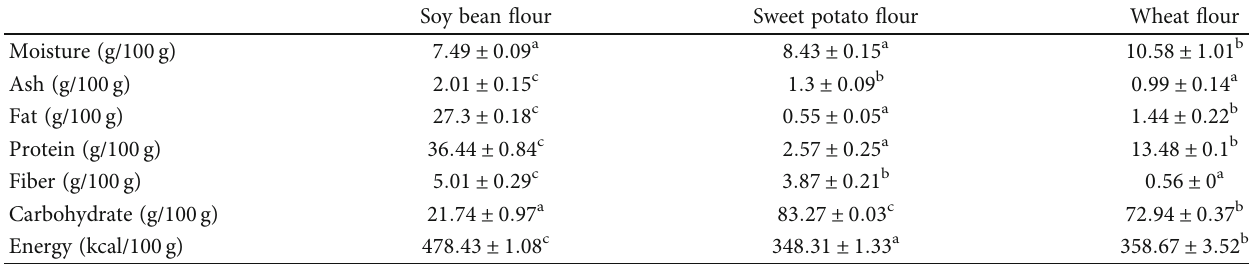
Table 2: Proximate composition of the di ff erent fl ours. Soy bean fl our Sweet potato fl our Wheat fl our